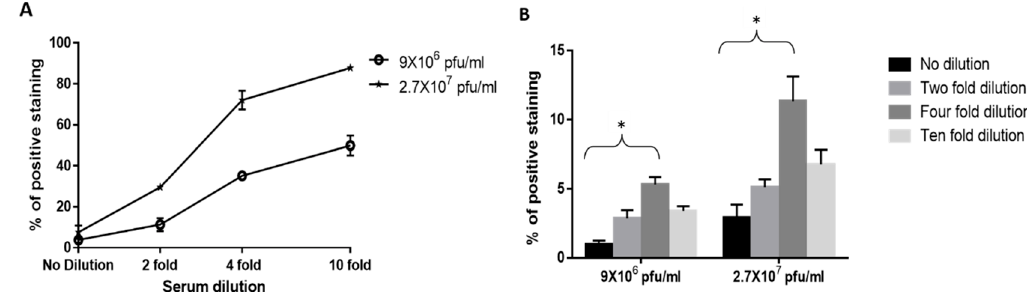
Figure 7. Adaption of the capture assay to commercial human serum. ( A ) Cells were harvested and diluted to achieve 20,000 cells per tube. WNV was spiked at the indicated concentrations into human serum or diluted serum. Next, the viruses were added to Vero cells and incubated for one hour with shaking at 4 °C to allow attachment. The cells were then immuno-labeled with anti-WNV:FITC antibody and analyzed by FACS. The results shown are average values of positive staining ± SEM from one experiment in biological duplicates. ( B ) WNV was spiked at 9 × 10 6 pfu/mL and 2.7 × 10 7 pfu/mL into commercial human serum. After spiking, the serum containing virus was diluted with PBS and then added to the cells for one hour with shaking at 4 °C to allow attachment. The cells were then immuno-labeled with anti-WNV:FITC antibody and analyzed by FACS. The results shown are from two experiments in biological duplicates. ( * ) Statistical significance was determined by 2 tailed unpaired student’s t -test. p value ≤ 0.05 was considered to be significant.